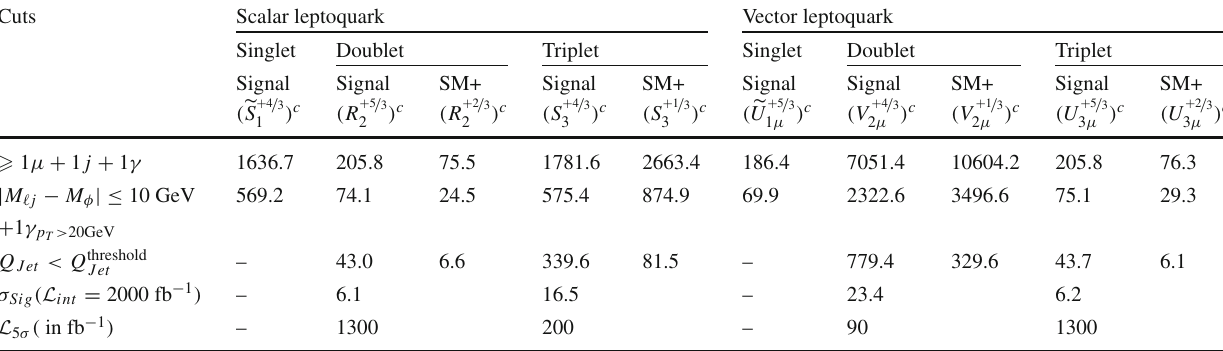
√ Table 16 Signal-background analysis for associated production of photon and different leptoquarks at FCC-II with s = 3464 . 1 GeV and = 2000 fb − 1 . The value of Q threshold L has been chosen 0 for R c and U c while the same for S c and V c is chosen to be − 0 . 3 int Jet 2 3 μ 3 2 μ Cuts Scalar leptoquark Vector leptoquark Singlet Doublet Triplet Singlet Doublet Triplet Signal Signal SM+ Signal SM+ Signal Signal SM+